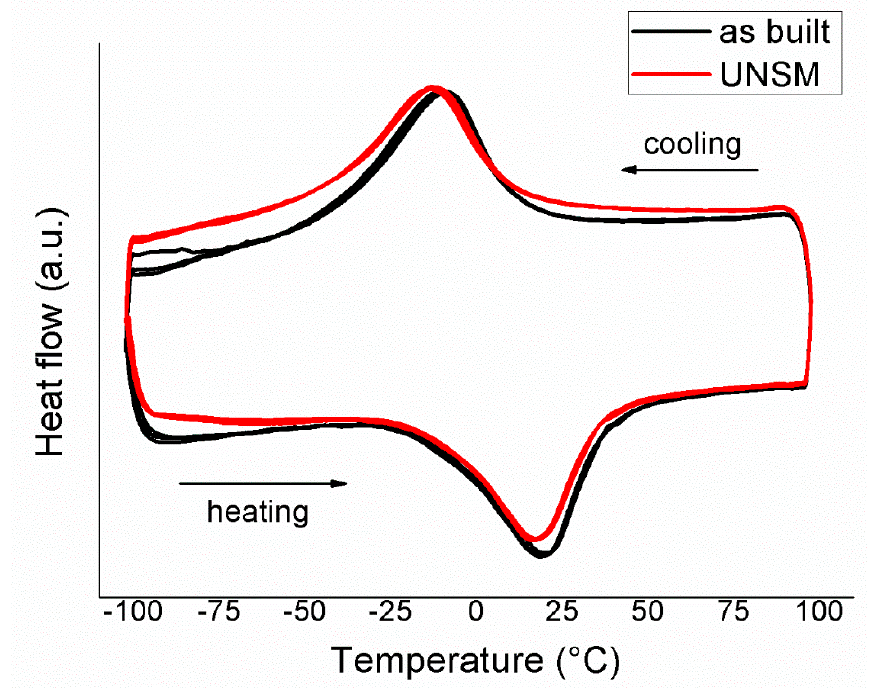
Figure 9. DSC scans of the as-built and UNSMed samples. Table 4. Transformation temperatures and enthalpies during the MT of as-built and UNSMed samples.